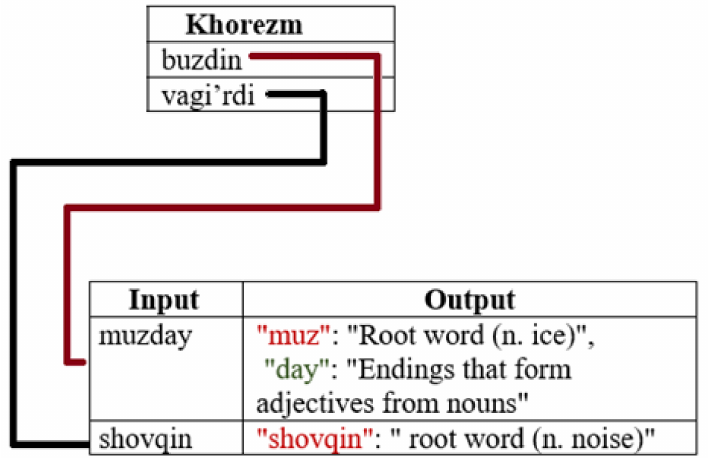
Figure 4. Final version of additional word